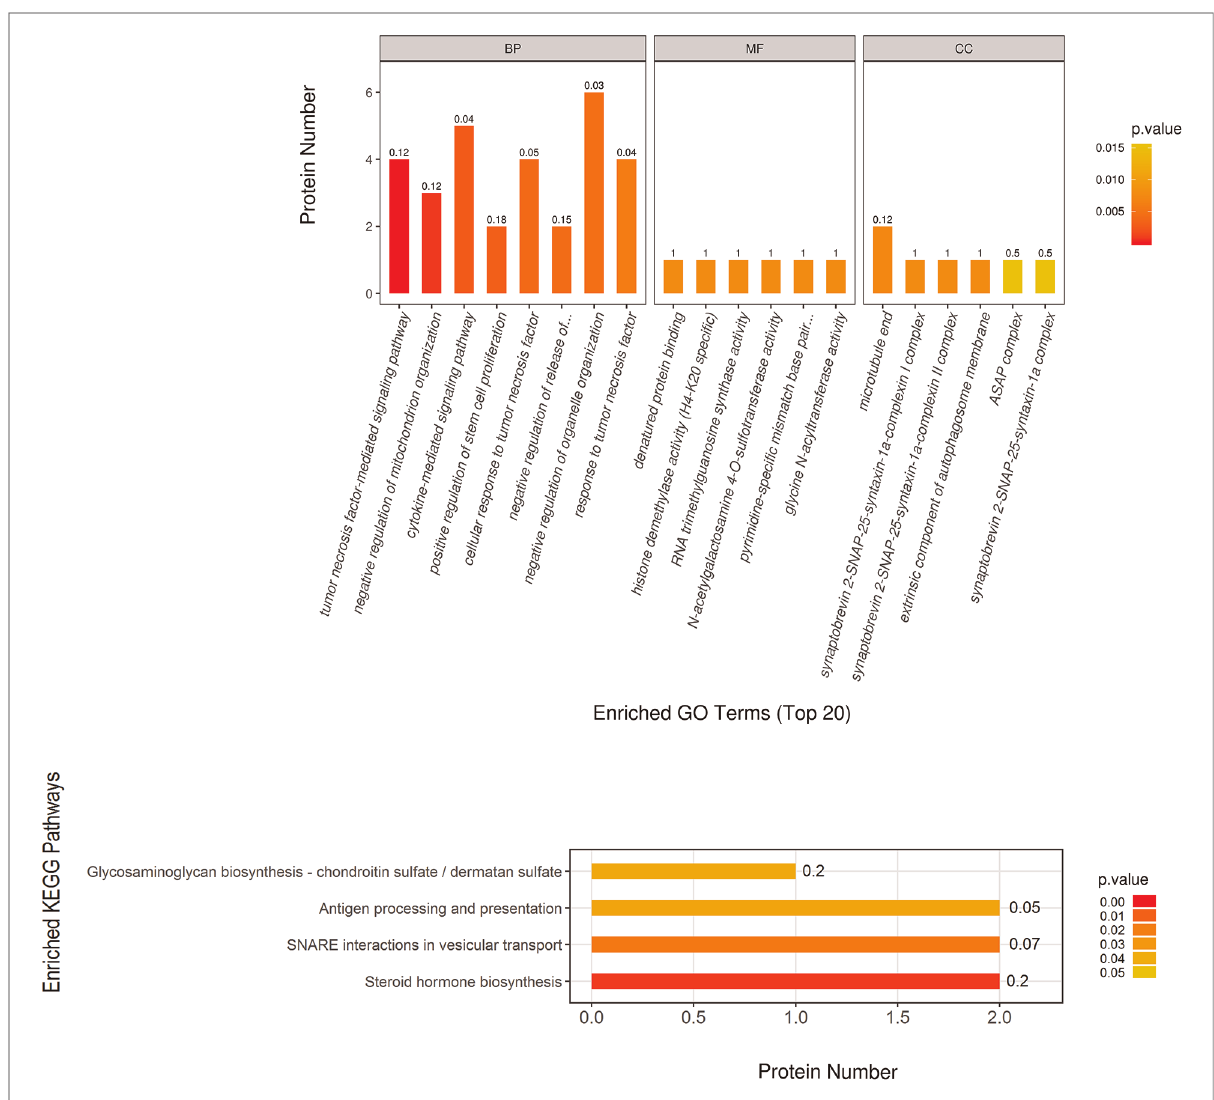
FIGURE 3 Signi fi cantly enriched GO terms and KEGG pathways, showing higher protein translating levels in the OVX+EX group than the OVX